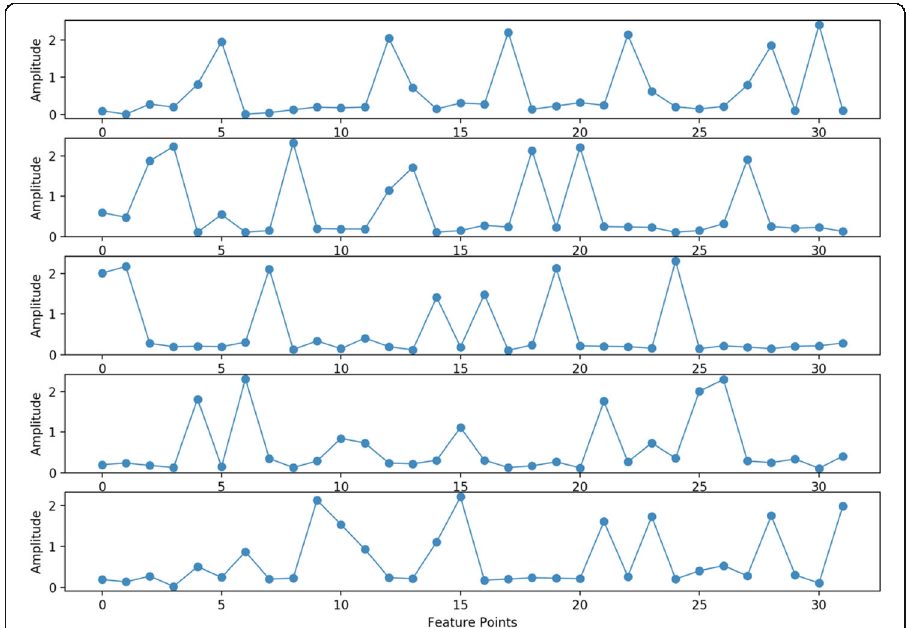
Fig. 13 batch chip feature map of